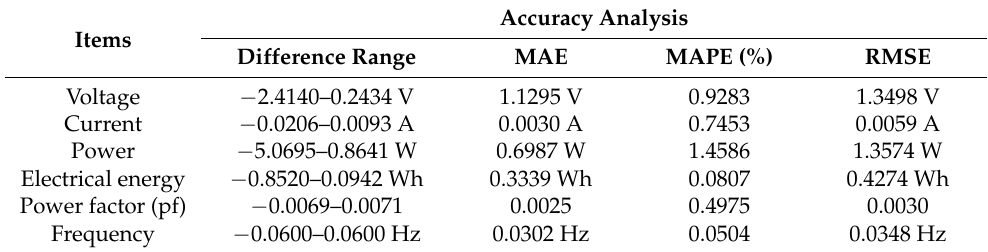
Table 3. Close agreement analysis of proposed AC power monitoring system for refrigerator.